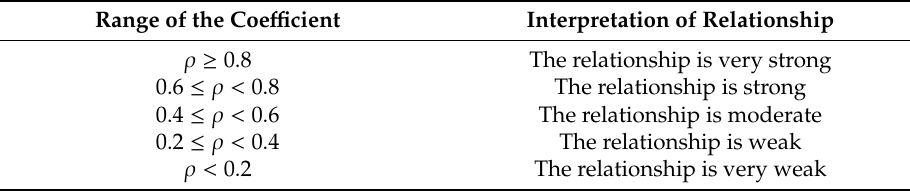
Table 10. Interpretation of Spearman’s correlation coe ffi cient [88].